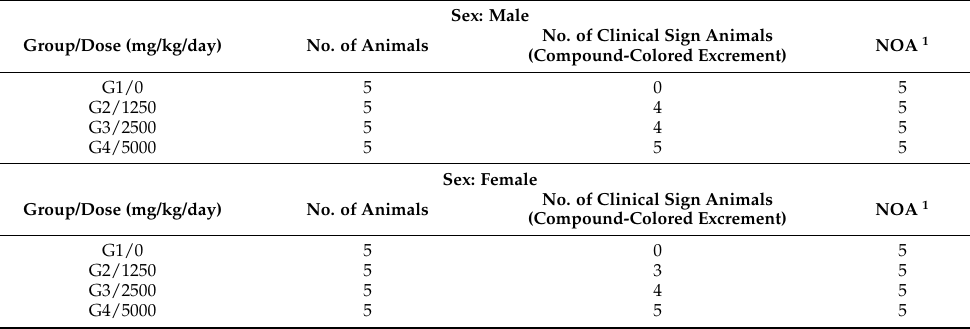
Table 3. Summary of Clinical Signs and Necropsy